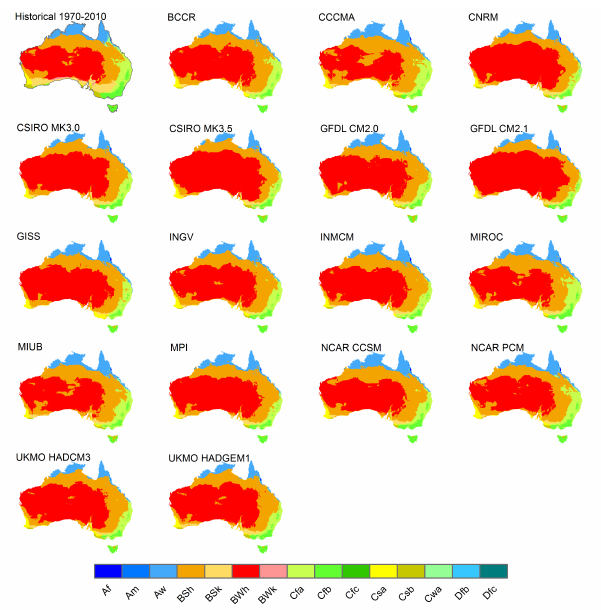
Fig. 2. K¨oppen-Geiger climate types under a future climate of +2.4 ◦ C derived from 17 GCMs (historical baseline period is in- cluded for reference).